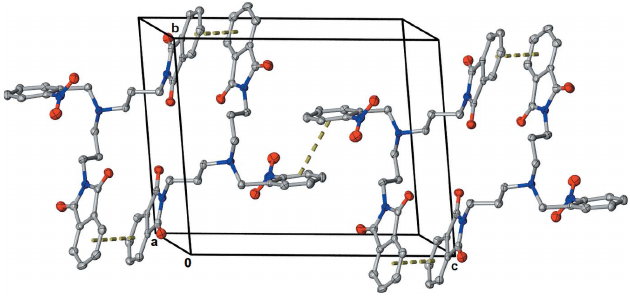
Figure 2 Molecular packing of the title compound showing the (cid:2) – (cid:2) interactions (dashed